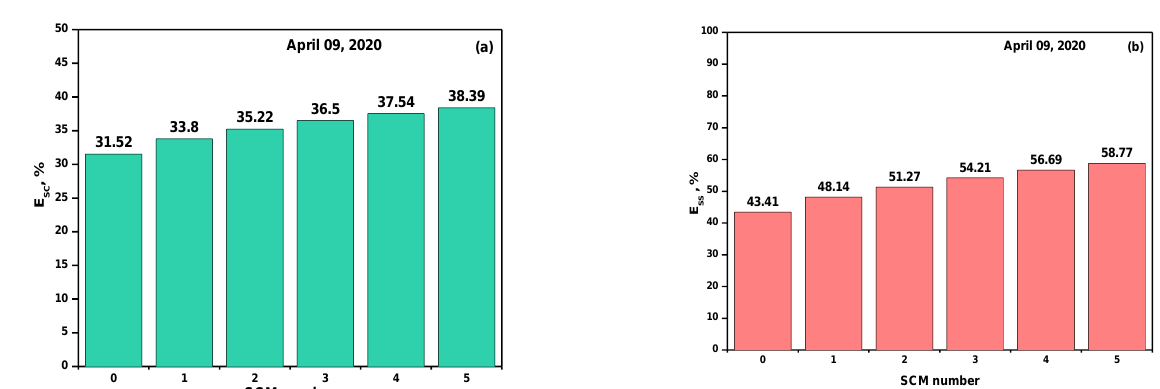
Figure 7. E SC percentage ( a ) and E SS percentage ( b ) for different numbers of SCM units and the partly cloudy day 9 April